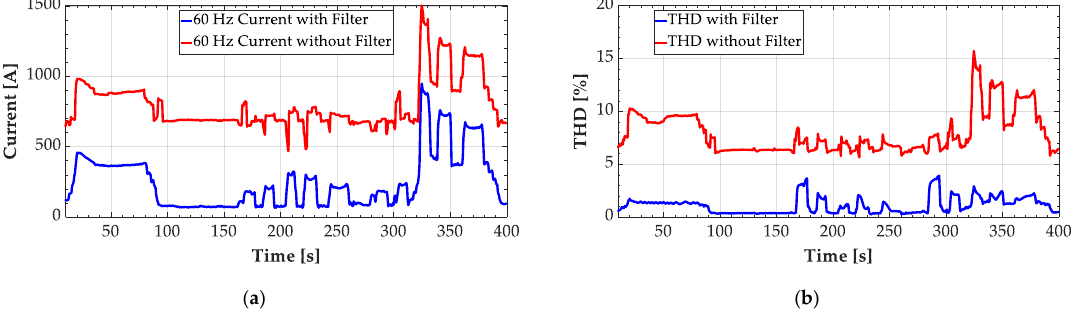
Figure 6. Electrical parameters from the point common coupling (PCC) with and without filter bank: ( a ) RMS value of the current upstream; ( b ) Total harmonic distortion (THD) of the voltage.